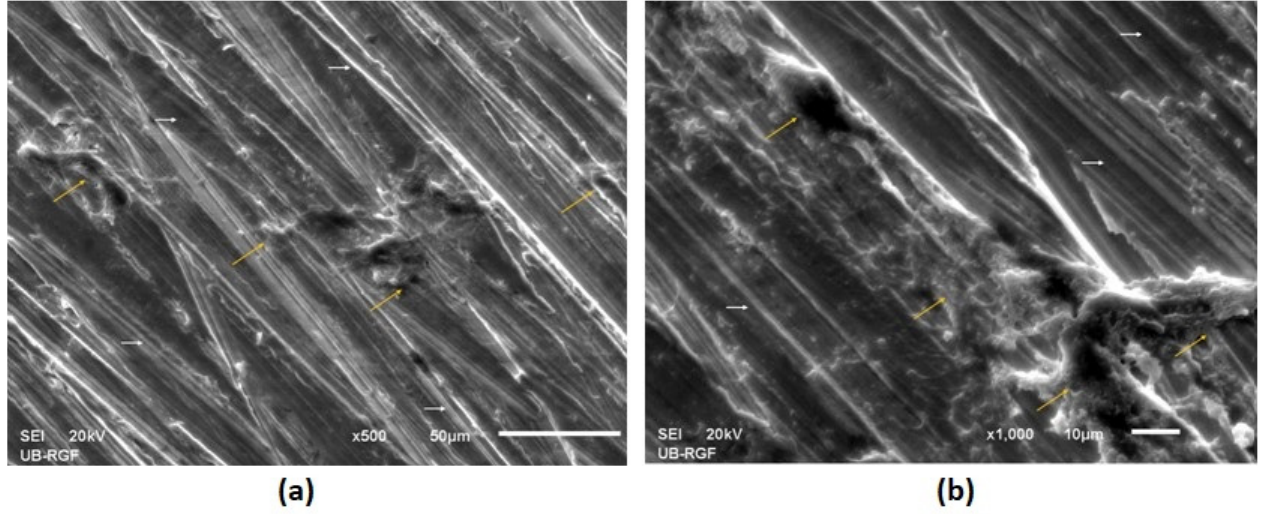
Figure 5. SEM micrograph: ( a ) 500 × magnification; ( b ) 1000 × magnification of fibroblast cells cultured on the Cu-Al-Ni disc surface. White arrows indicate material relief, and yellow arrows indicate cells.